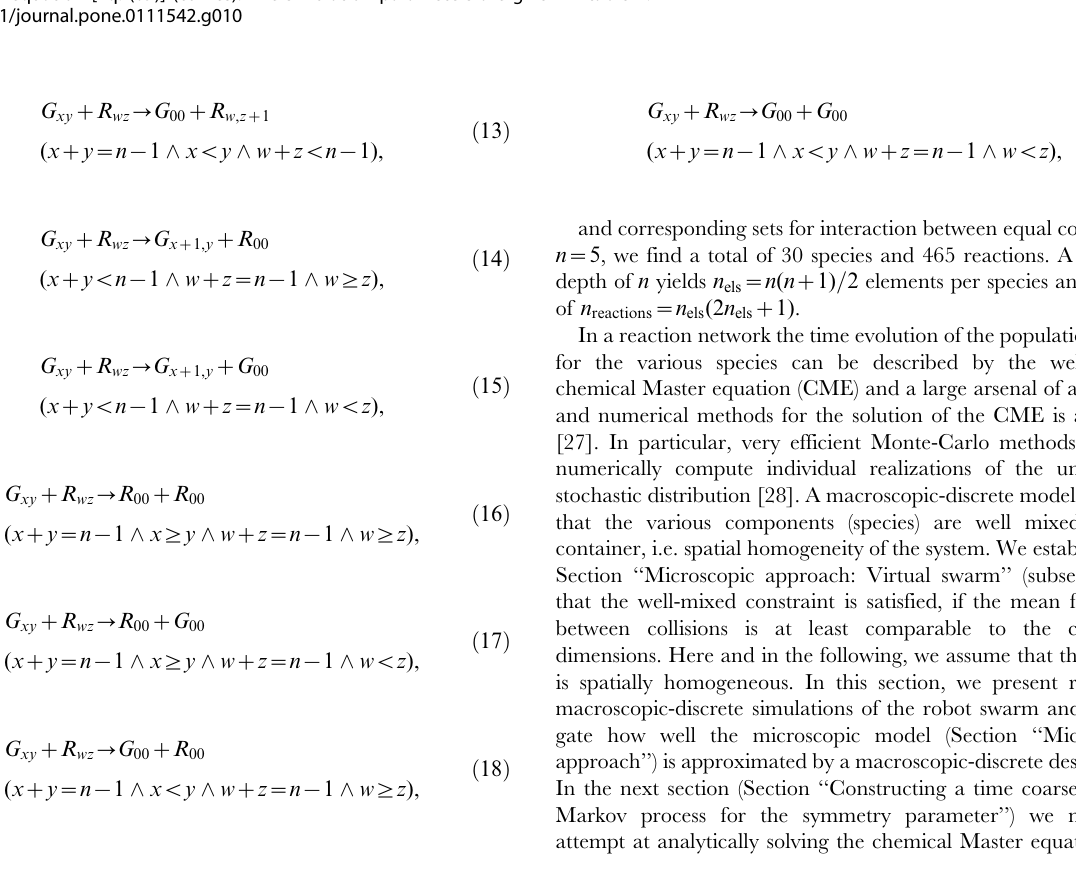
Figure 10. Comparison of properties of a flame simulation designed to mimic the kilobot swarm for different values of the avoidance radius d a . Also compare Fig. 9). Shown are results for d a ~ 4 cm (blue curves and markers), d a ~ 6 cm (red curves and markers) and d a ~ 8 cm (green curve and markers). The experimental setup is described in Section "Kilobot experiments’’ (subsection 1). (top panels) Jump probabilities W z ( s k ) (left) and W { ( s k ) (right) for the Master equation (10) as inferred from the experiment records [Eq. (63)]. (bottom left panel) Splitting probability p ( s k ) , as estimated directly from the experimental records [cf. Eq. (53)] (markers) and computed using the solution of the Master equation Eq. (68) (curves). (bottom right panel) Decision time T ( s k ) as estimated from the experiment records [Eq. 58] (markers) and computed from the Master equation [Eq. (69)] (curves). The simulation parameters are given in table 2.